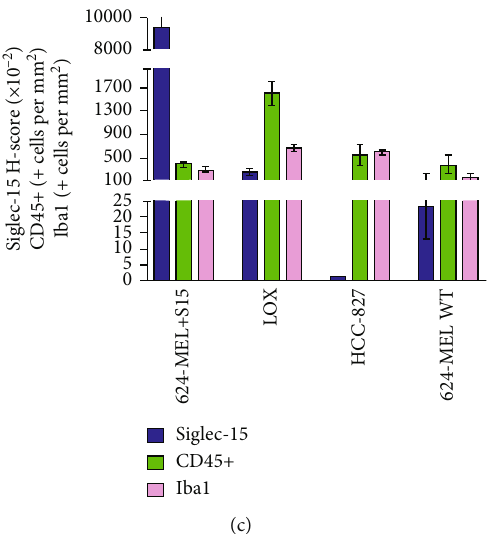
Figure 7: (a) Representative images of H&E and IHC stained sections (CD45, Iba1, and Siglec-15) from 624-MEL+S15, LOX IMIV, HCC- 827, and 624-MEL WT tumors. (b) Comparison of individual tumor necrosis (%; estimated from H&E staining) and vessel density (estimated from CD-31 IHC staining) for the 4 tumor types. (c) IHC quantitative analysis of Siglec-15 expression levels (staining intensity score and H -score) and the number of positive cells per mm 2 for CD45 and Iba1 of the tumor types; each bar represents the mean ± SE ( n = 8 , 624-MEL+S15 tumors; n = 6 , LOX IMIV, HCC-827, and 624-MEL WT